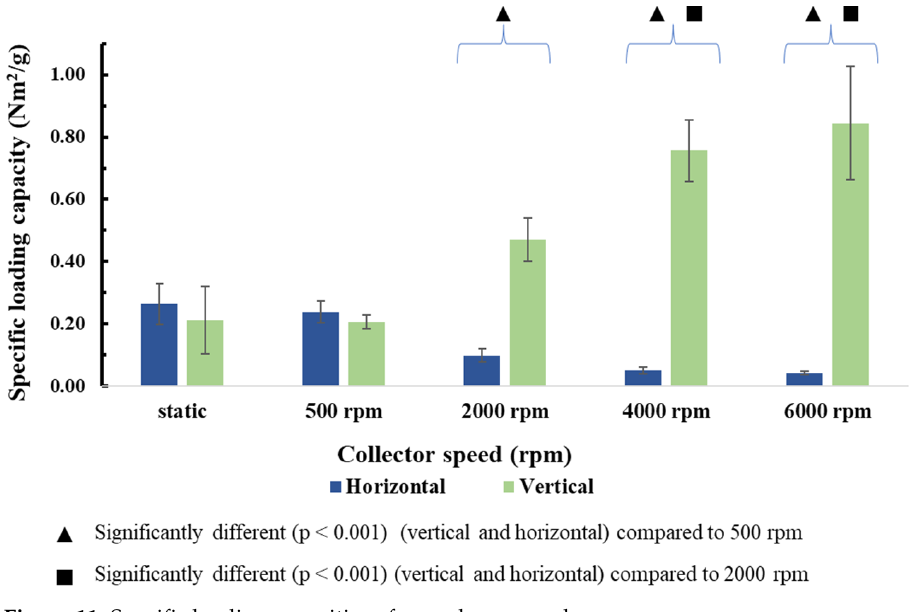
Figure 11. Specific loading capacities of monolayer membranes.